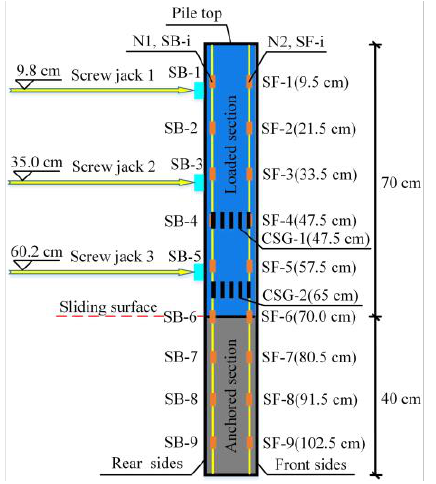
Figure 7. Layout diagram of screw jacks and steel strain gauges.